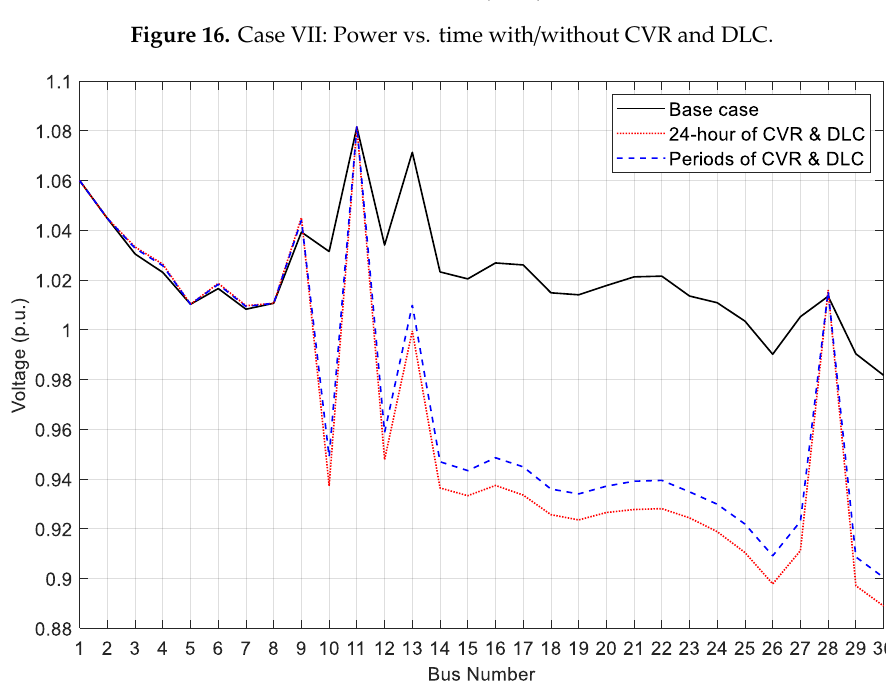
Figure 17. Case VII: Voltage profile with/without CVR and DLC.